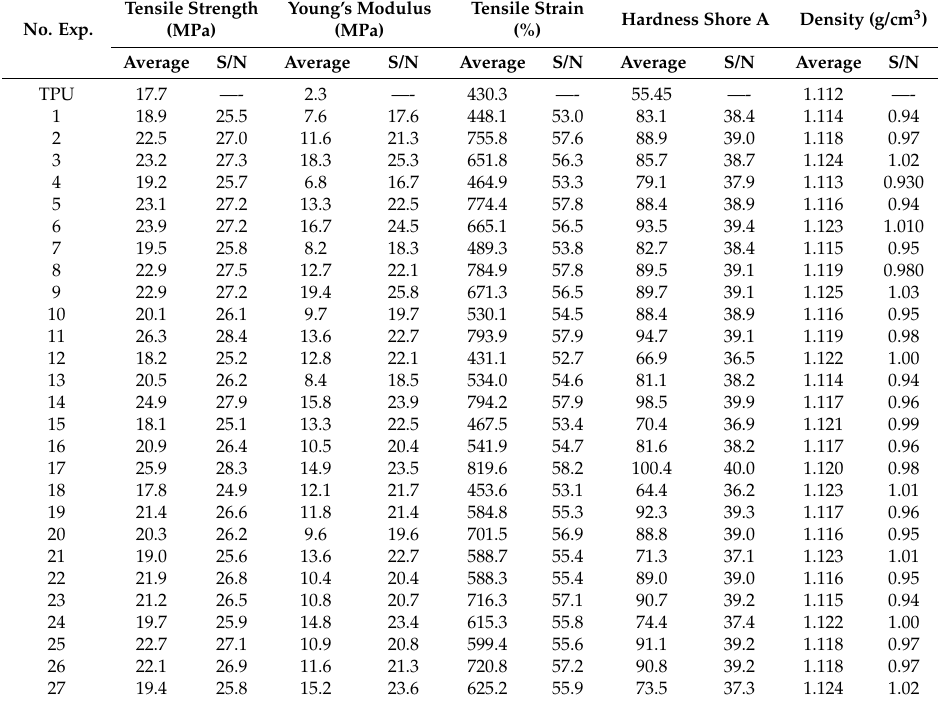
Table B1. Summary of the mechanical and physical property